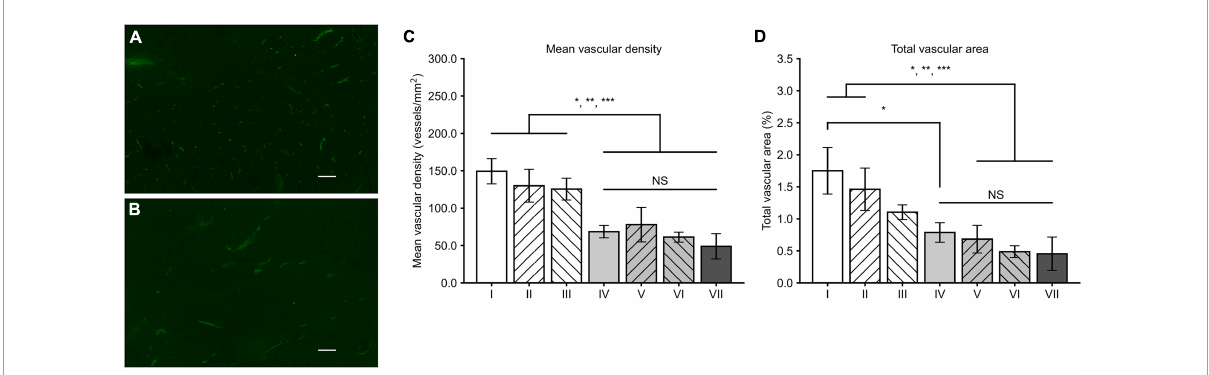
FIGURE1 Tumor CD34 stainings and analysis of MVD and TVA. CD34-positive microvessels in the groups II (A) and VII (B) with a magnification of 100 × and scale bar of 100 µ m. Density of microvessels is visibly higher in a tumor from the group II. (C) In general, MVD was lower in all the groups receiving sVEGFR2 and/or sVEGFR3 gene therapy (groups IV–VII) when compared to the groups I–III. (D) Similar to MVD results, TVA was generally lower in the groups IV–VII while difference to the group III was less prominent. Results were considered statistically significant with values of p < 0.05*, p < 0.01**, and p <